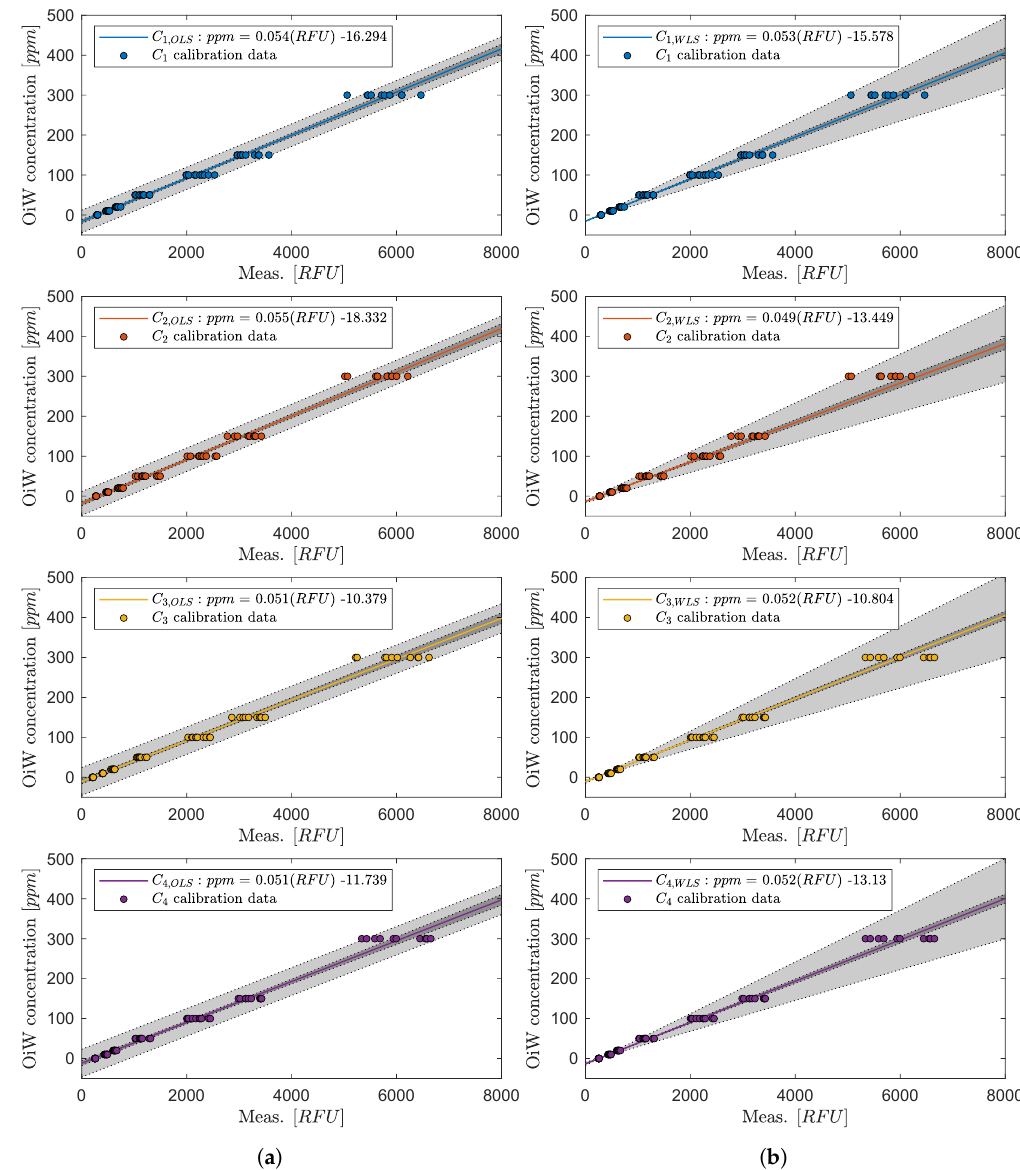
Figure 3. Parameter calibration for each of the four OiW monitors fitting to a linear regression: ( a ) illustrate the linear regression using OLS. ( b ) illustrate the linear regression using